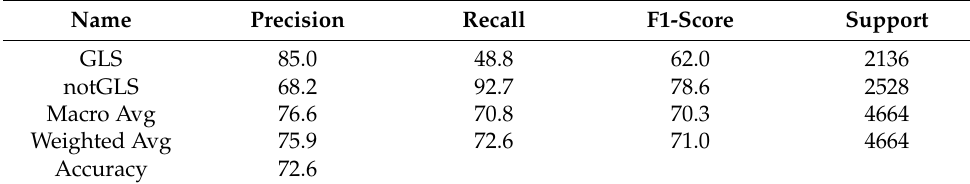
Table 10. Performance of GLS_net_noBackground upon the IFNB testing set.